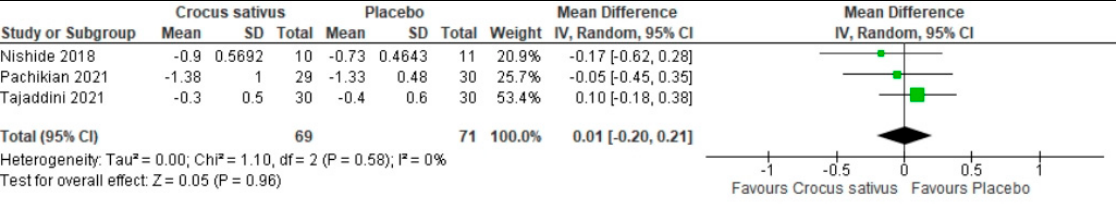
Figure 9. Forest plot for the outcome sleep disturbances [26,27,30]. Note: Line indicates confidence interval and the green square indicates effect estimate. Black diamond indicates cumulative effect estimate and its confidence interval.